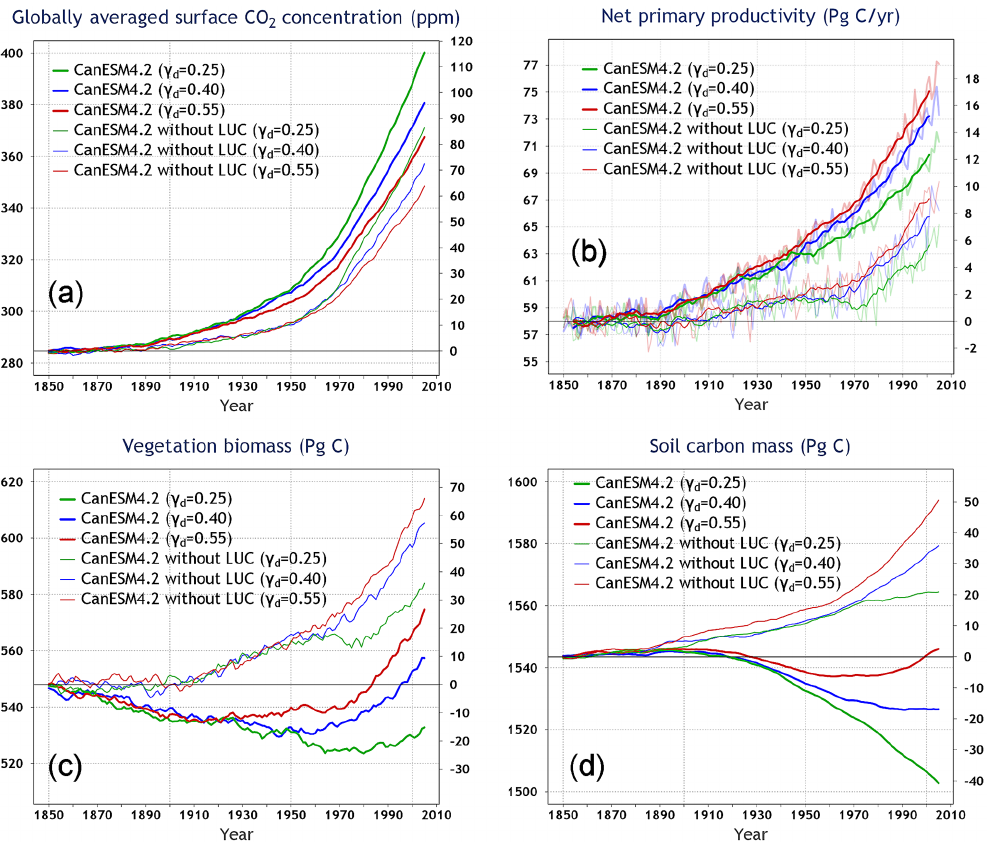
Figure 10. Comparison of CanESM4.2 simulations with and without implementation of anthropogenic land use change over the historical period for three different strengths of the terrestrial CO 2 fertilization effect: (a) globally averaged annual surface atmospheric CO 2 concen- tration, (b) net primary productivity, (c) global vegetation biomass, and (c) global soil carbon mass. All lines are the average of results from two ensemble members. Additionally, in (b) the bold lines are the 10-year moving